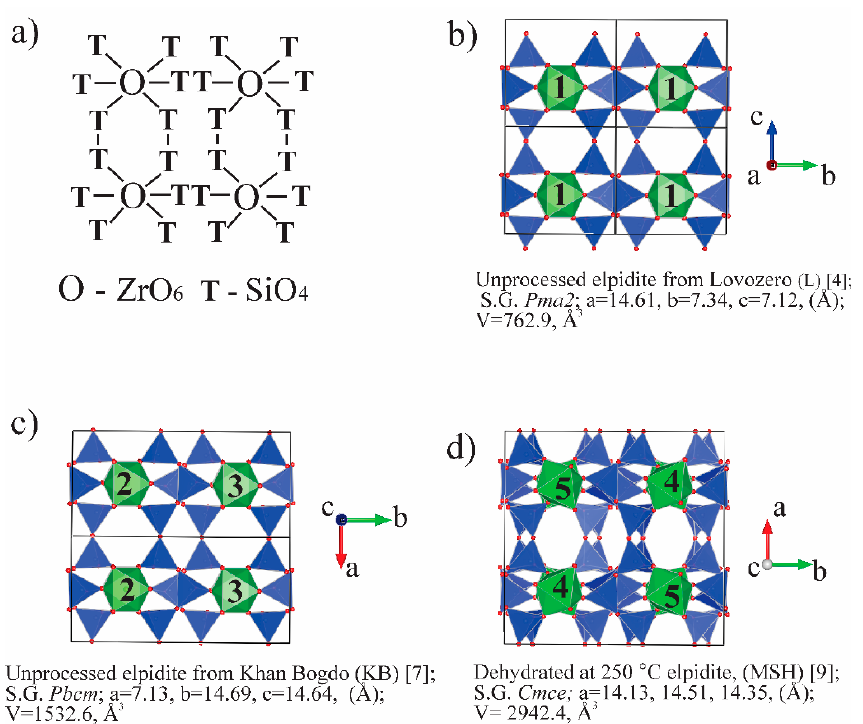
Figure 2. Spatial orientation of ZrO 6 octahedra in the structures of Pma2- , Pbcm- , and Cmce- elpidites. ( a ) idealized scheme of elpidite framework topology; ( b ) crystal structure of unprocessed elpidite (L) [4]— Pma2 ; ( c ) crystal structure of unprocessed elpidite (KB) [7]— Pbcm ; ( d ) crystal structure of dehydrated at 250 °C elpidite (MSH) [9]— Cmce .